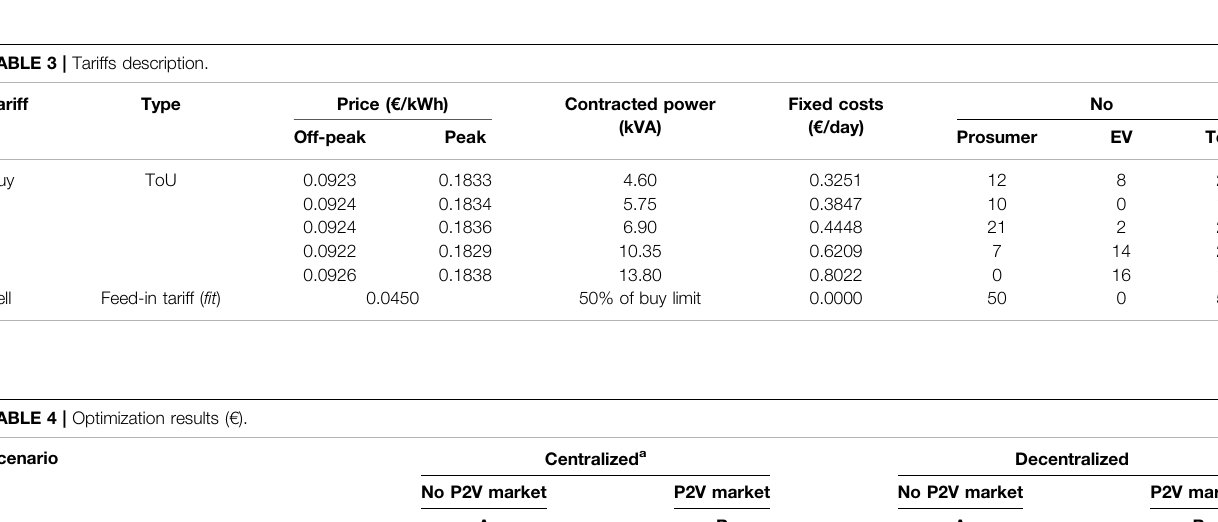
FIGURE 4 | EV pro fi les, (A) movements, and (B) mean consumption.